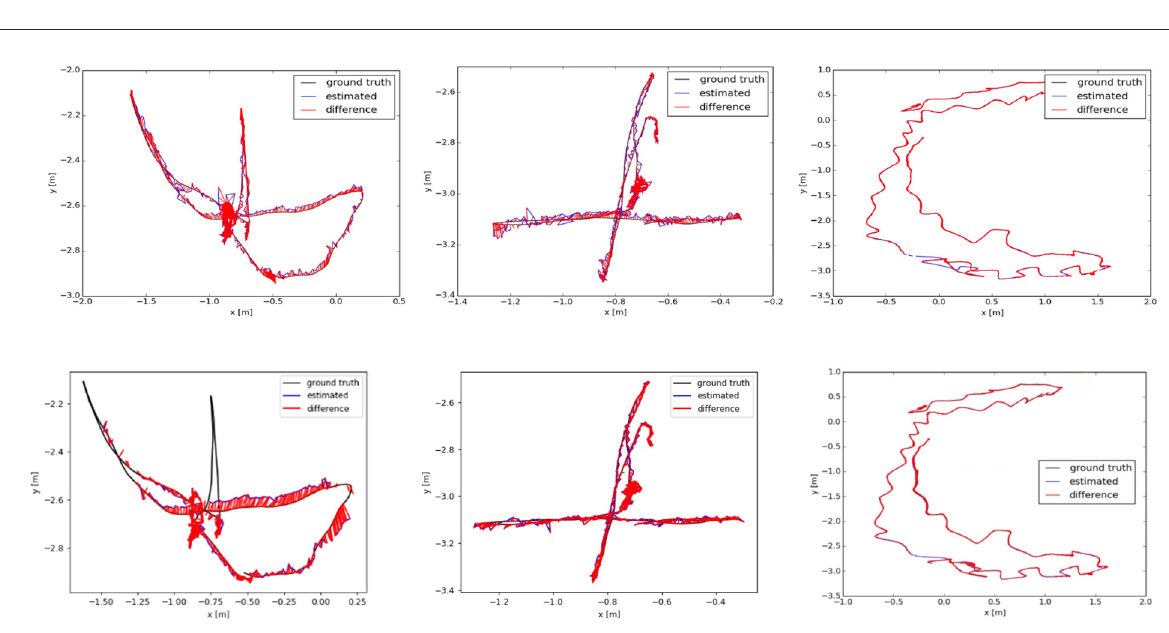
data set are much better than ORB-SLAM2. Compared